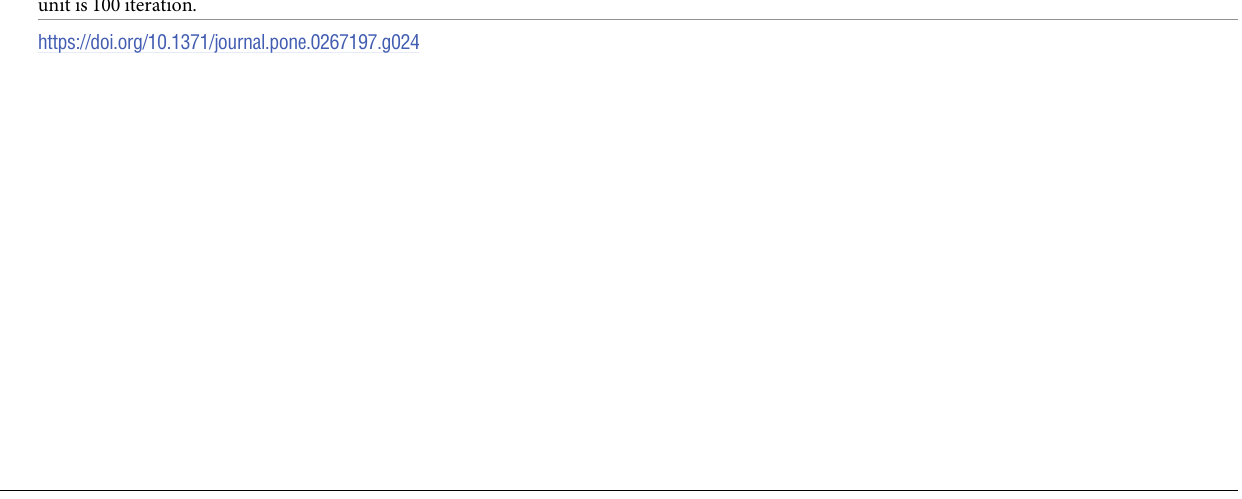
PLOS ONE | https://doi.org/10.1371/journal.pone.0267197 May 2, 2022 23 /